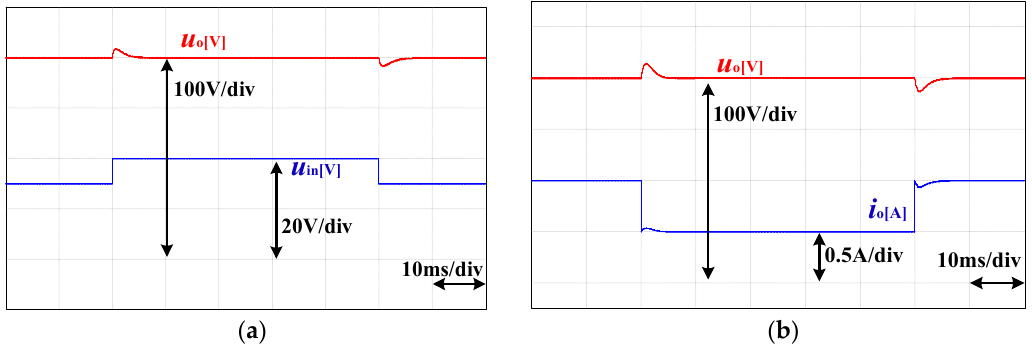
Figure 14. Simulation waveforms for ( a ) step changes of input voltage; ( b ) step changes of load resistance.